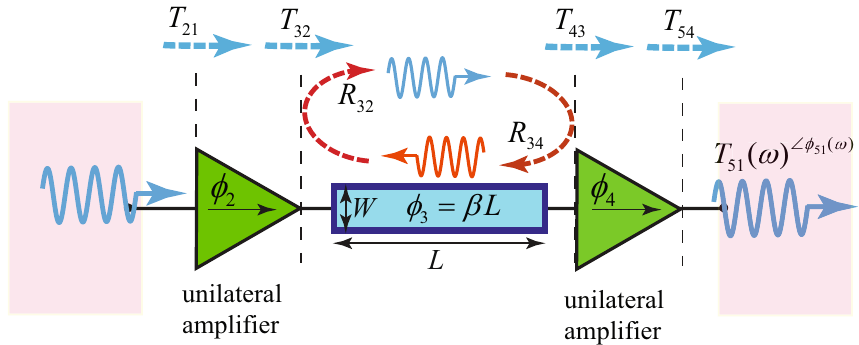
Figure 5. Illustrative schematic of the multiple reflection and transmission inside the super-cell. By controlling the transmission phase shift and magnitude of the super-cell, arbitrary phase shifts and transmission magnitudes can be achieved at a given frequency across the frequency band via different parameters of the unilateral amplifiers and central phase